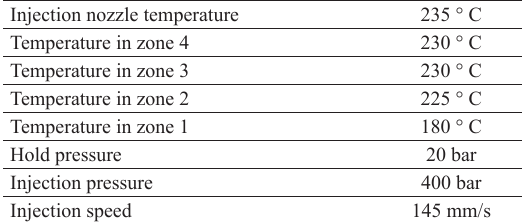
Table 2. Parameters used in the injection process of virgin PP and PP/15wt% bamboo